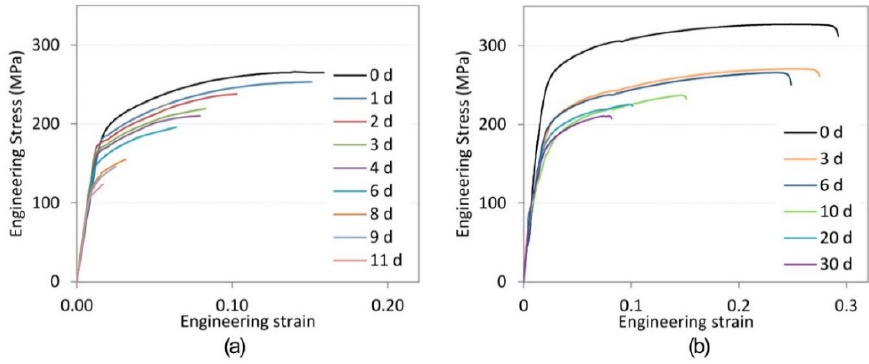
Figure 2. Representative stress–strain curves for ( a ) dog-bone and ( b ) wire specimens over time. Error bars omitted for clarity (n = 3).